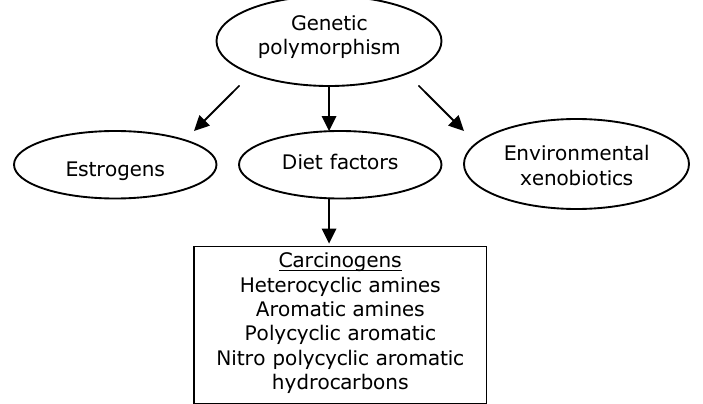
Figure 5 . Genetic